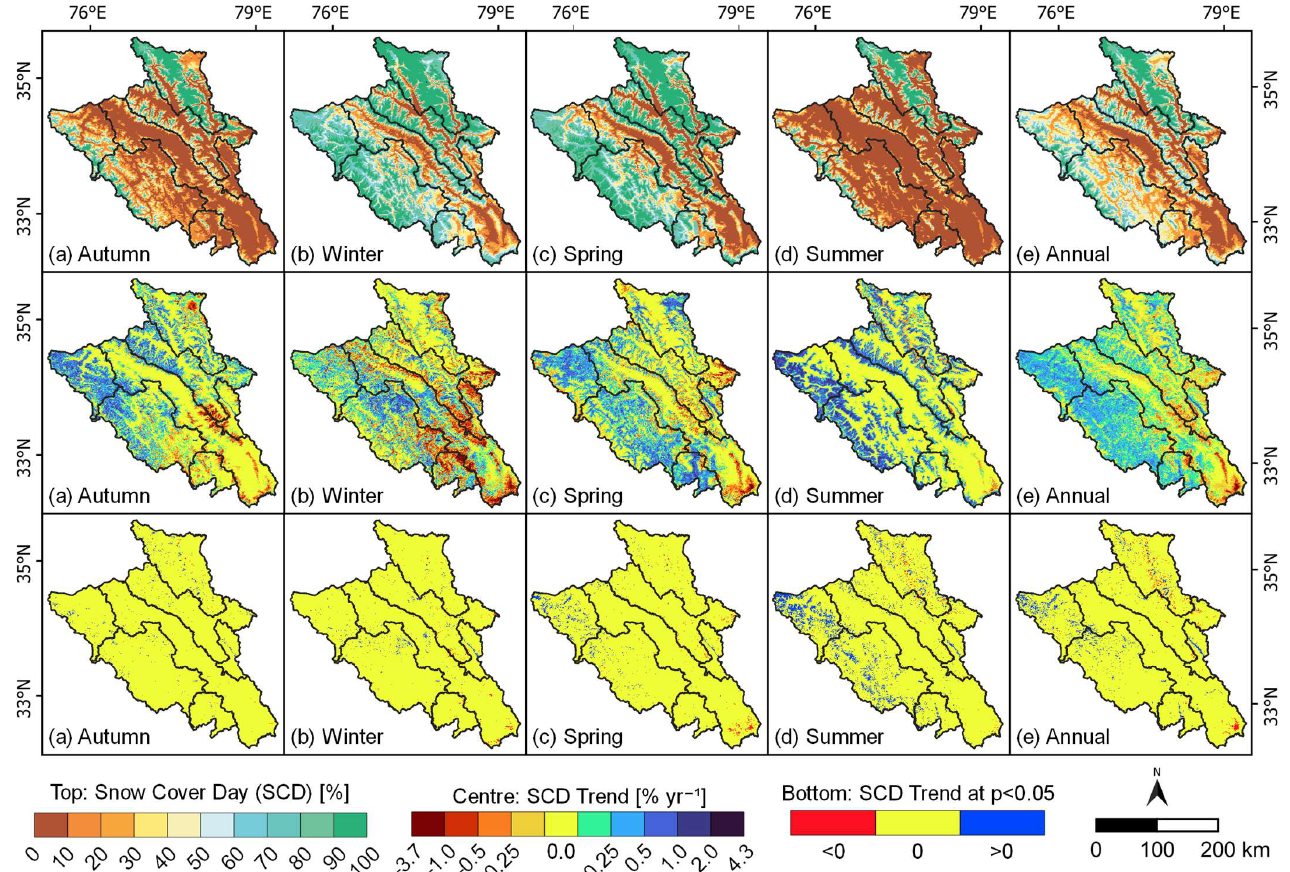
Figure 9. Pixel-wise analysis of snow cover days (SCD) for the entire study area of Ladakh over the period of 2000–2019. Mean seasonal and annual SCD ( top ), seasonal and annual trends of SCD ( a ) autumn: September–November, ( b ) winter: December–February, ( c ) spring: March–May, ( d ) summer: June–August, and ( e ) annual (hydrological year: October–September) ( centre ). SCD trends with significance level p < 0.1, yellow colour symbolizes no significant trend, red negative, and blue colour positive trends ( bottom ).